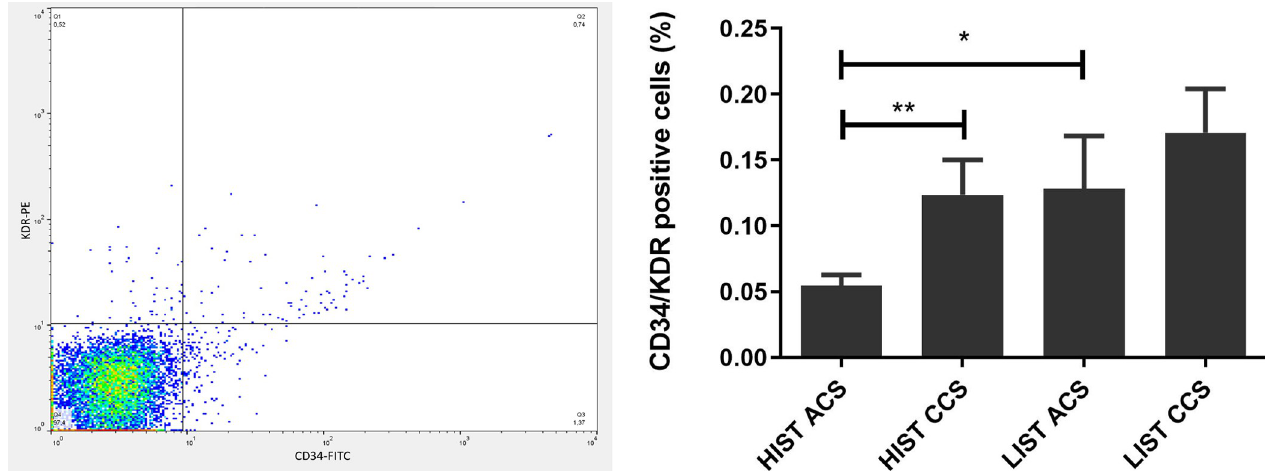
Fig 3. Reduced percentage of CD34+/KDR+ cells under HIST. FACS analysis with double fluorescence with PE-labelled KDR and FITC-labelled CD34 antibodies. Double positive cells are indicated in the upper right quadrant (left).